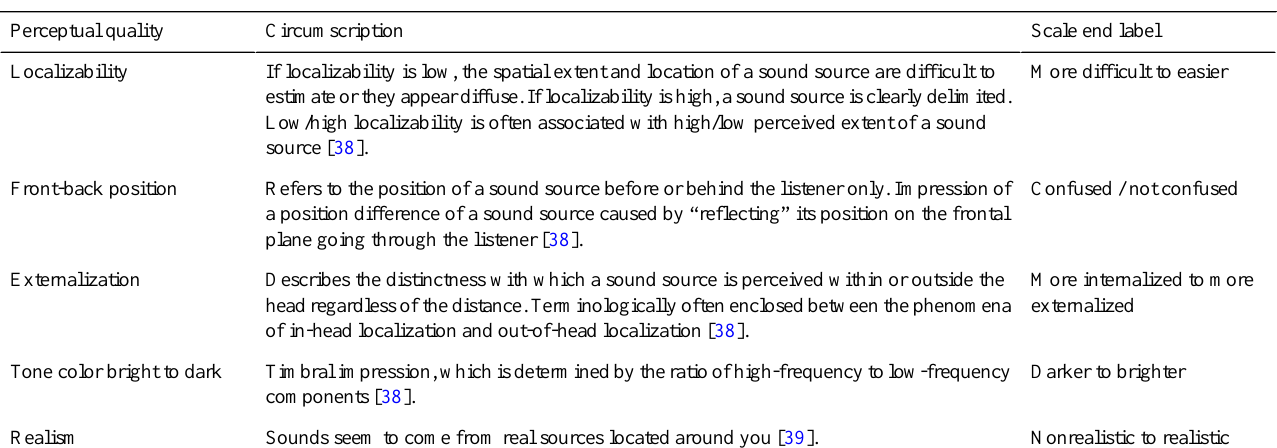
Table 1. Perceptual qualities for the assessment of the audiovisual scene derived from the studies on spatial audio quality inventory [38] and that of Simon et al